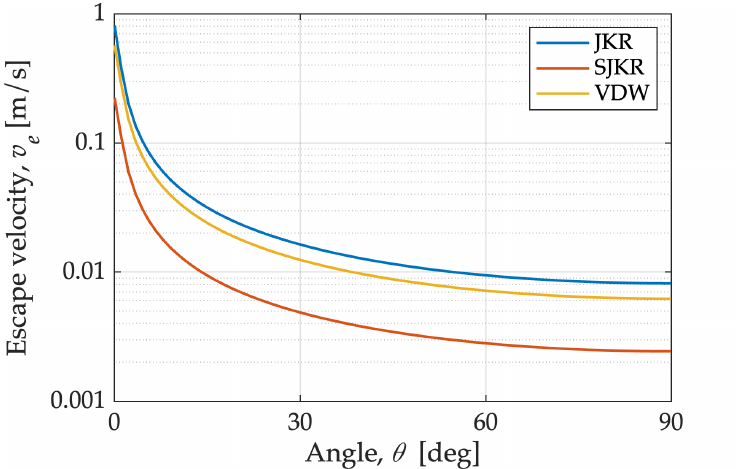
Figure 10. Escape velocity as a function of angle for different cohesion